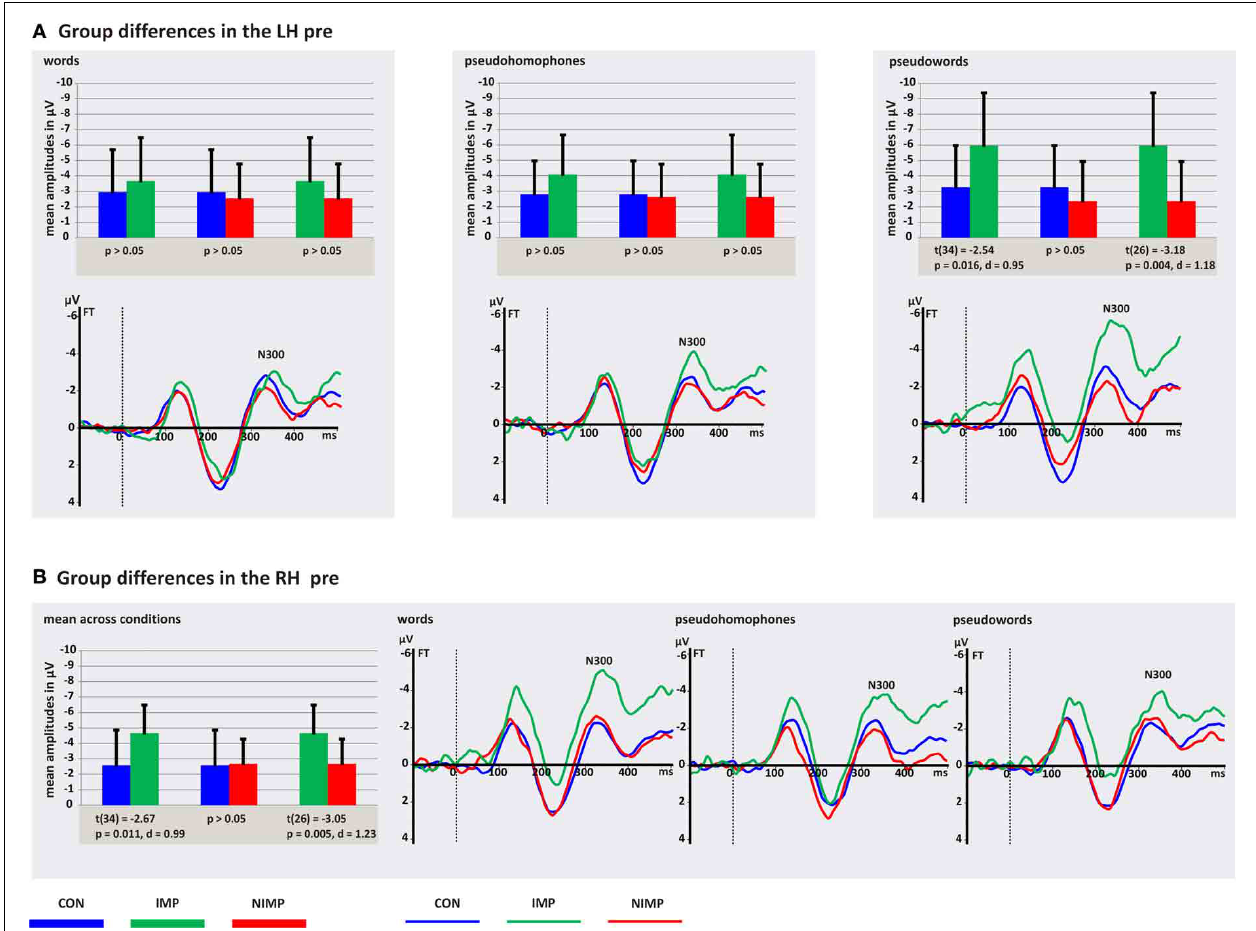
FIGURE 4 | N300 mean peak amplitudes for control children (CON), improvers (IMP), and non-improvers (NIMP) before intervention. (A) Illustrates group differences in the left hemisphere (LH). (B) Depicts group